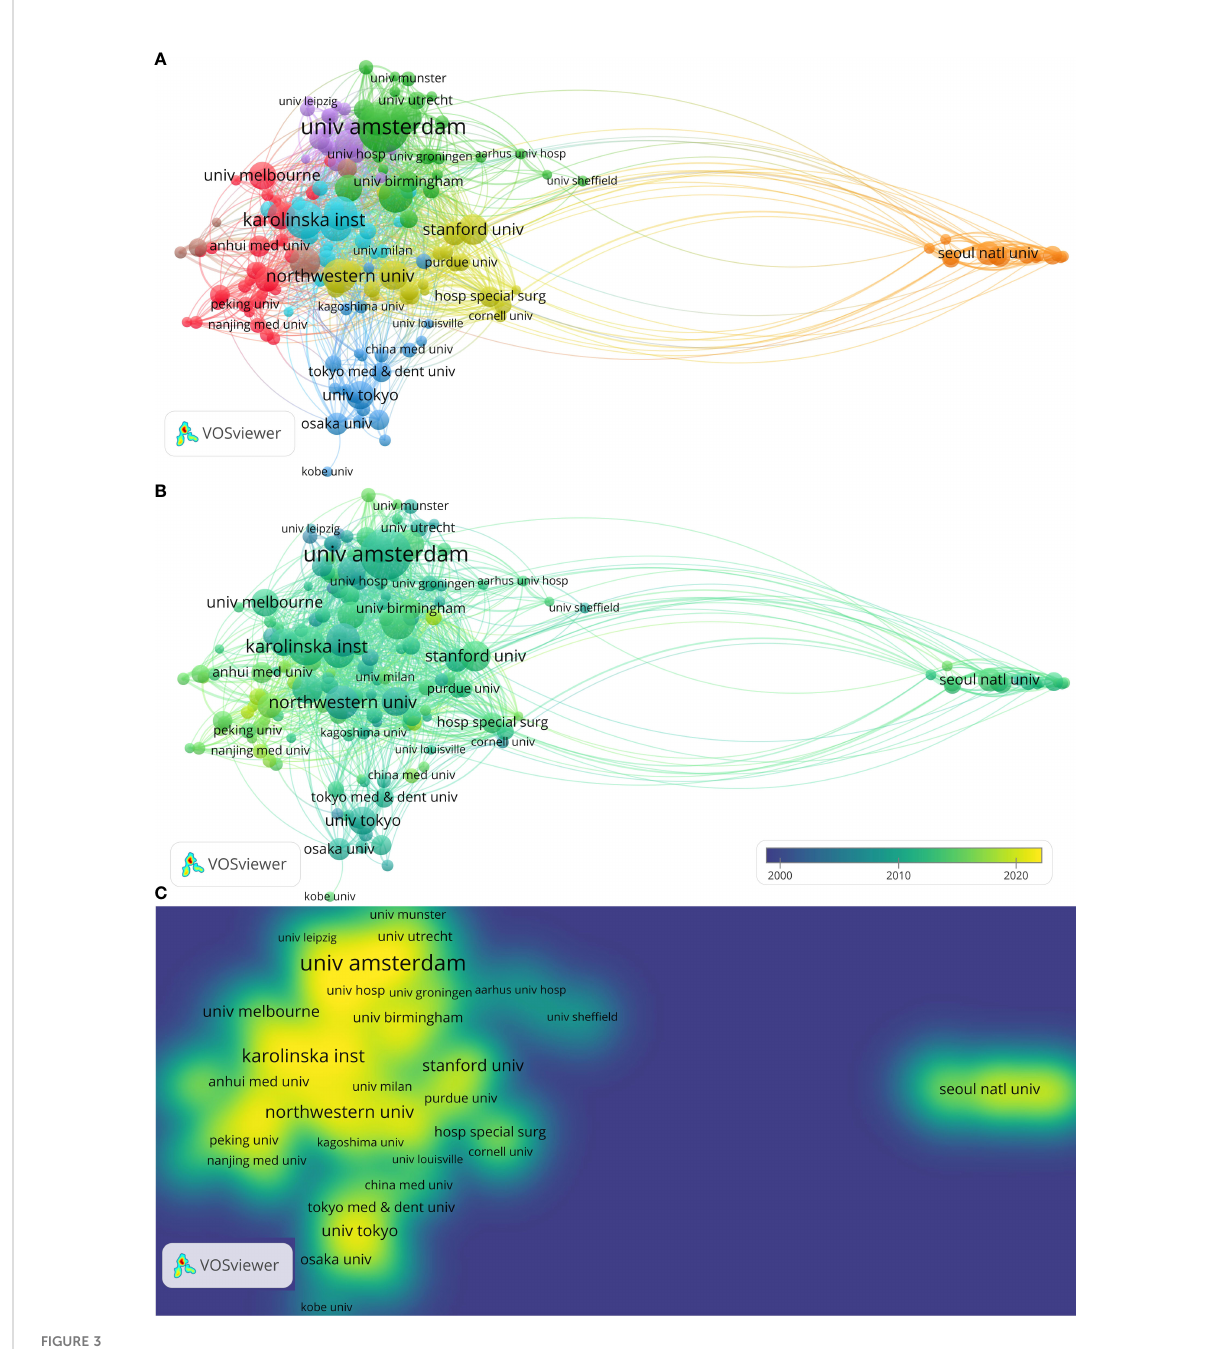
FIGURE 3 Cluster analysis of publications from different institutions from 2000-2021. (A) Cluster analysis of publications from different institutions. (B) Evolution of publications from different institutions. (C) Evolution of publications from different institutions